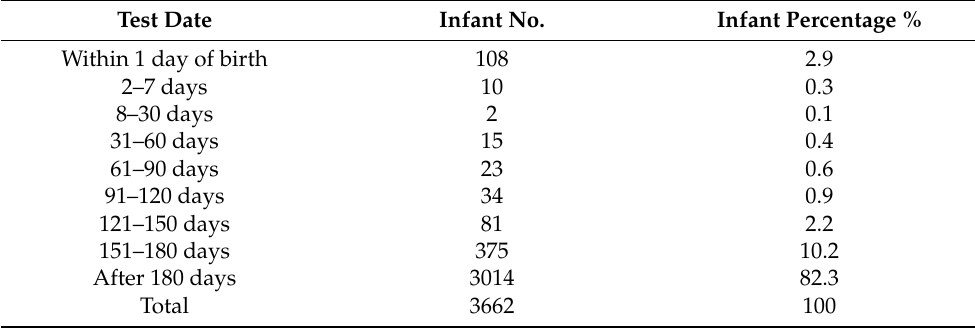
Table 4. Test date (infant age) of the 1st diagnostic auditory brainstem response in